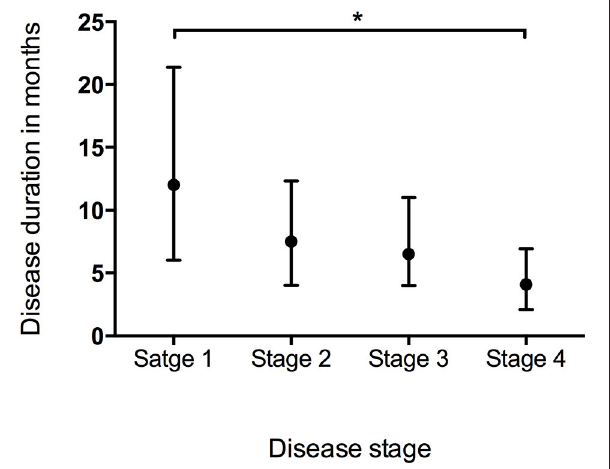
FIGURE 1 | Box plot of duration in months spent at each stage representing median and range of values. * P < 0.05.